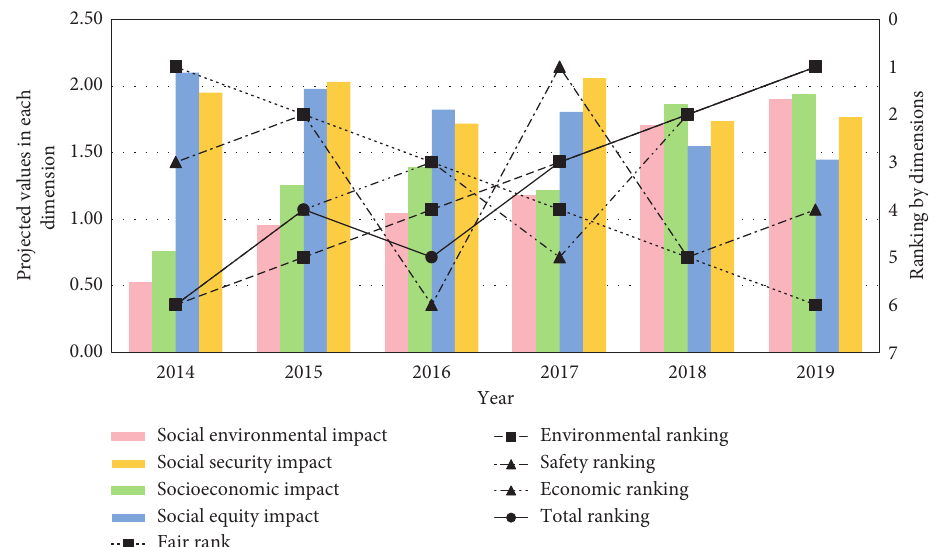
Figure 5: Projected values and rankings in each dimension (the higher the projection value and ranking, the higher the overall score for social impact).